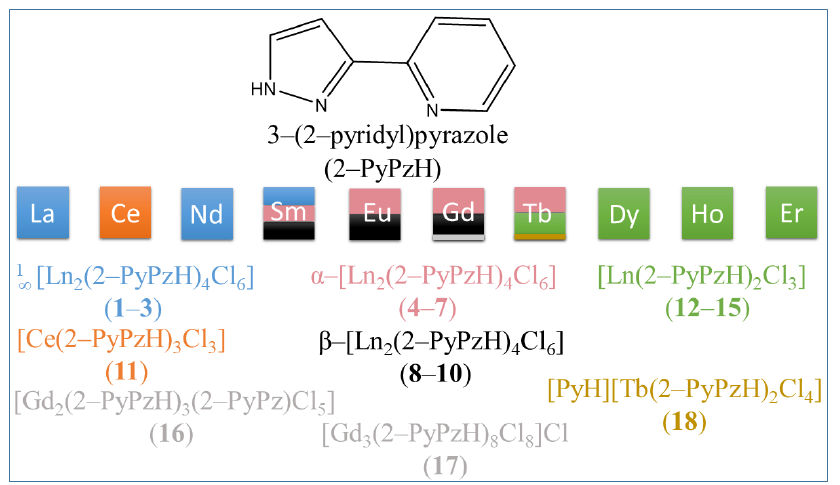
Scheme 1. Structural diversity and polymorphism of the products from the reactions of respective anhydrous LnCl 3 with 2–PyPzH. The color changes indicate a different crystal